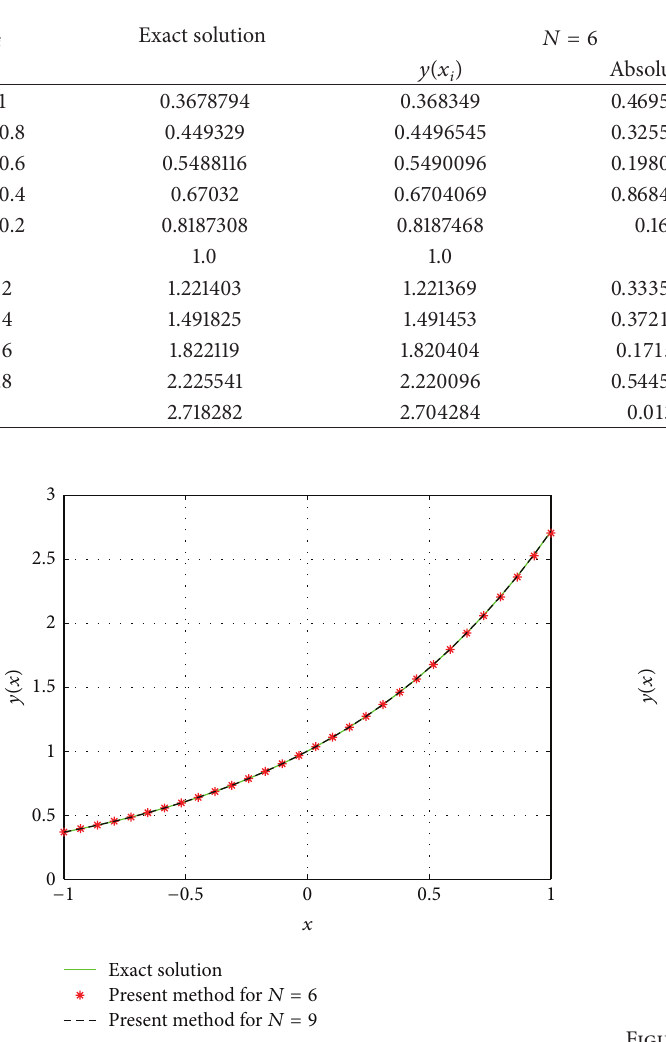
Figure 2: Numerical and exact solutions of Example 3 for 𝑁 = 6,9 .